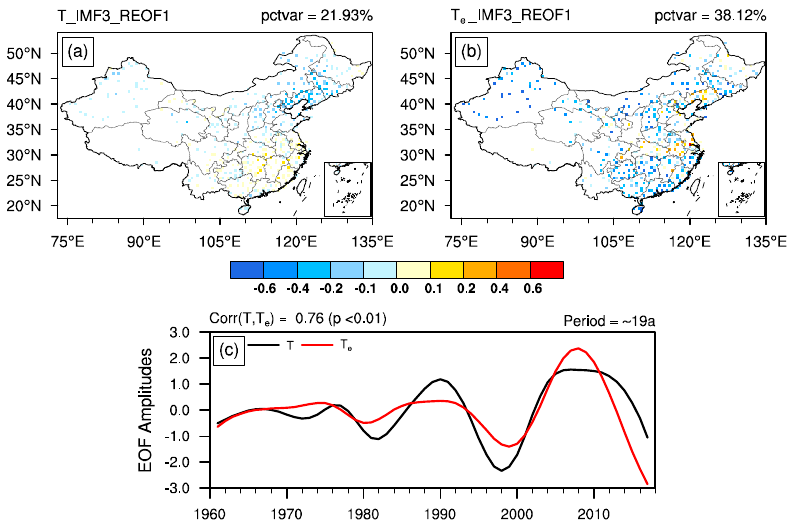
Figure 4. The first REOF modes of the IMF 3 of summertime T ( a ) and T e ( b ) in China, and the corresponding principal component ( c ). Note that the “pctvar” in the figure means percent variance; “Corr” means correlation coefficient between T and T e ; Black (Red) line represents the principal component of T ( T e ).